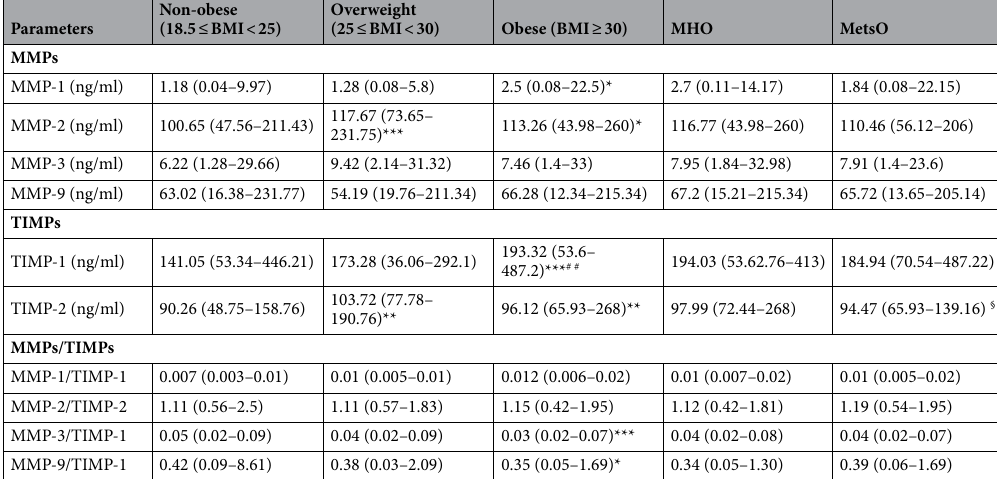
(Supplementary Table 1). Bêta coefficient (β) for valences indicates the direction of the relationship between the predicted variable and the independent variables. In this regard, the probabilities of MMP-2, TIMP (-1 and -2) levels and MMP-2/TIMP-2 ratio have been increased in obese subjects (Supplementary Table 1). Spearman correlation of MMP‑1 and MMP‑2 plasma levels with anthropometric parameters (BMI and WC).